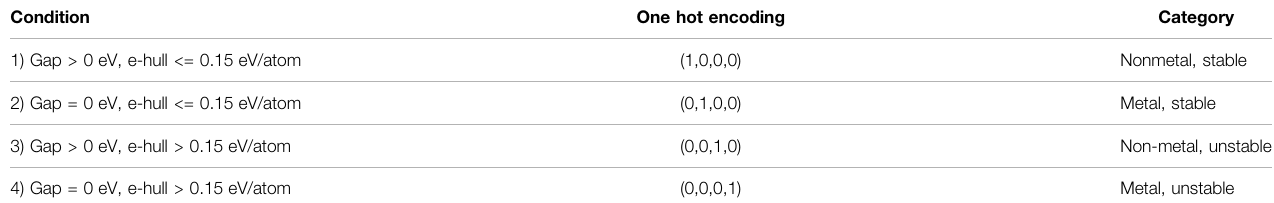
TABLE 1 | Classi fi cation of the 2D materials in our dataset into four different classes based on their bandgap and energy above the hull values. Condition